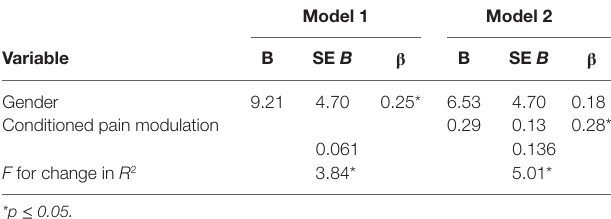
Table 2 | Hierarchical regression for predicting variables of pain decrease in an LCL environment.